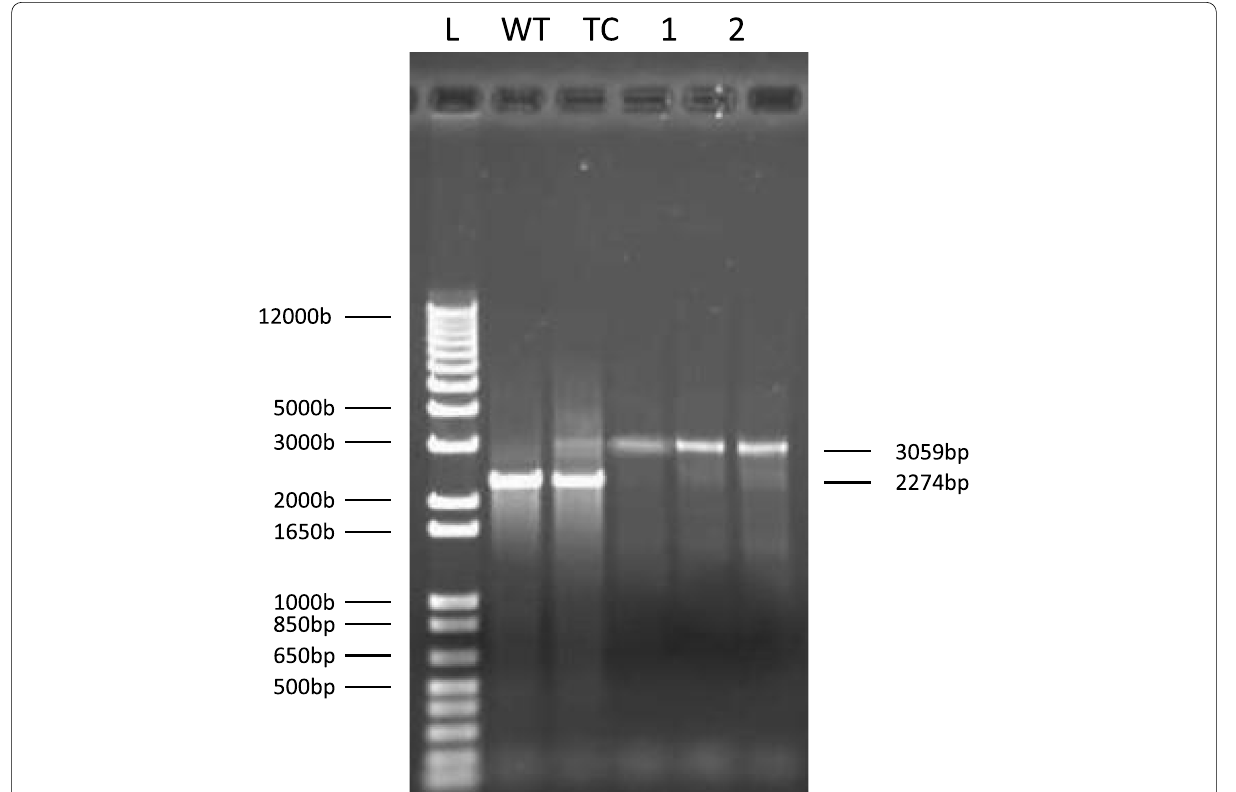
Fig. 1 Conformation of the mutant strains by PCR. 1 Kb plus DNA ladder (L). Wild type gene of icl locus (WT). PCR of transconjugants showing both mutated and wild type region of icl (TC). PCR of icl mutants showing the mutated icl after double crossover (1,2, and